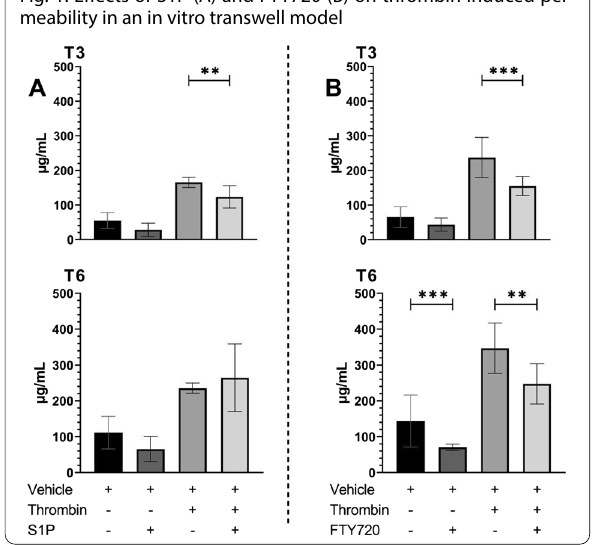
Fig. 1. Effects of S1P (A) and FTY720 (B) on thrombin induced per- meability in an in vitro transwell